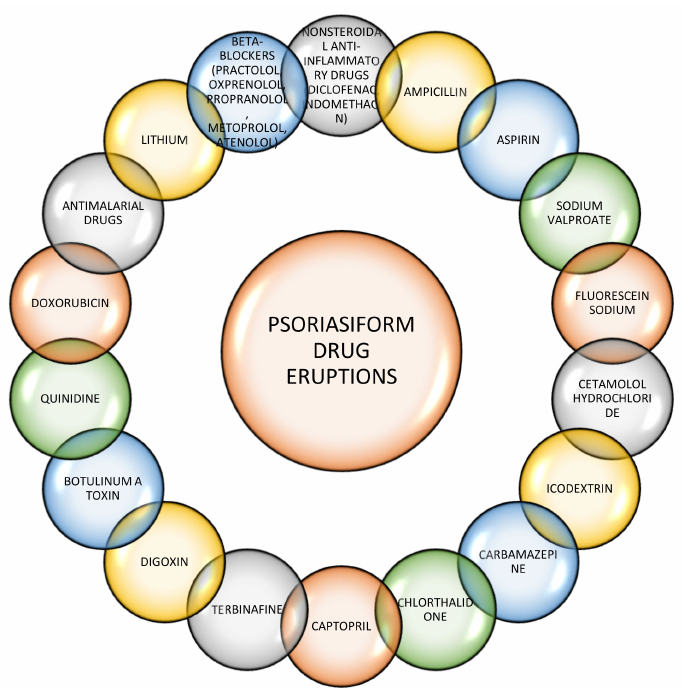
Figure 2. Several drugs have been implicated in psoriasiform drug eruptions, trigger